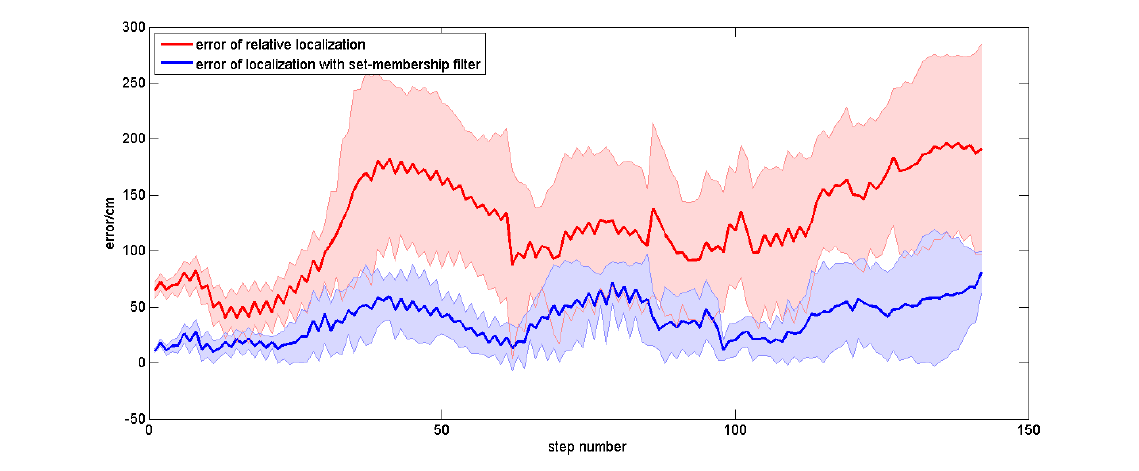
Figure 21. The mean error curves of Subject A walking with small steps.